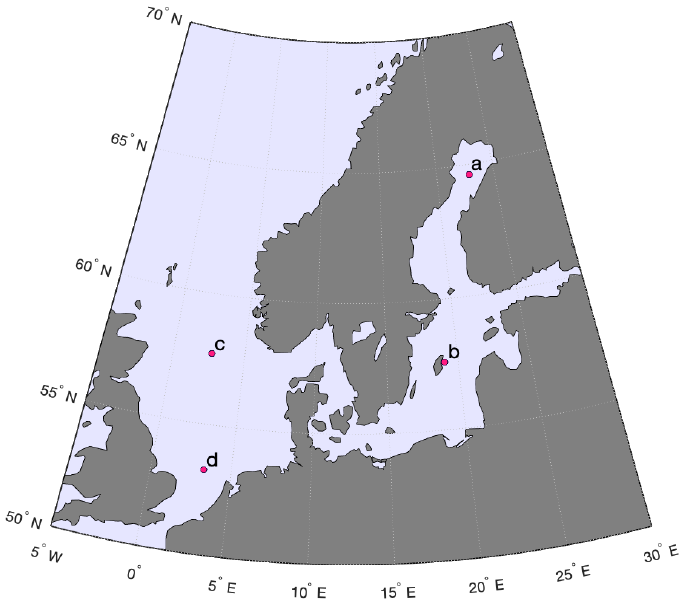
Figure 5. The map of chosen locations for a model runs: ( a , b )– the Baltic Sea; ( c , d )—the North Sea. These regions were chosen as a study region due to the high quantity of chosen pollutants in the system [25]; large differences in hydrodynamic, meteorological and biological conditions [42–44]; and also, a high risk for bioaccumulation due to the high primary production, negatively affecting food safety